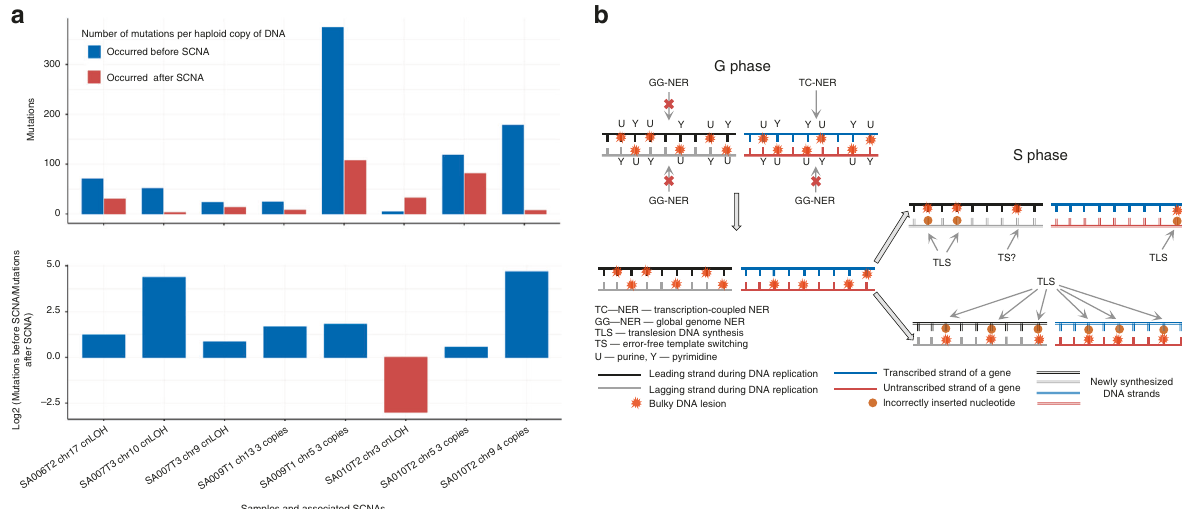
Fig. 5 Accumulation of DNA lesions and mutations observed in XP-C tumors. a Relative number of mutations that occurred before and after SCNAs in XP-C cancer genomes (normalized per haploid DNA copy number). The majority of events demonstrate an excess of mutations that were accumulated before the SCNA and may have occurred in tumor-progenitor cells or at early stages of carcinogenesis. b A model of DNA lesion accumulation and mutagenesis in XP-C cells. In XP-C cells where GG-NER is dysfunctional, bulky lesions cannot be ef fi ciently repaired and persist everywhere in the genome except transcribed strands of active genes where TC-NER is operative. During the S-phase a part of bulky lesions on the leading strand may be removed by error-free template switching (TS) mechanisms while on the lagging strand they are converted to mutations by error-prone translesion synthesis (TLS) more frequently, causing mutation accumulation with cell divisions and observed transcriptional and replication